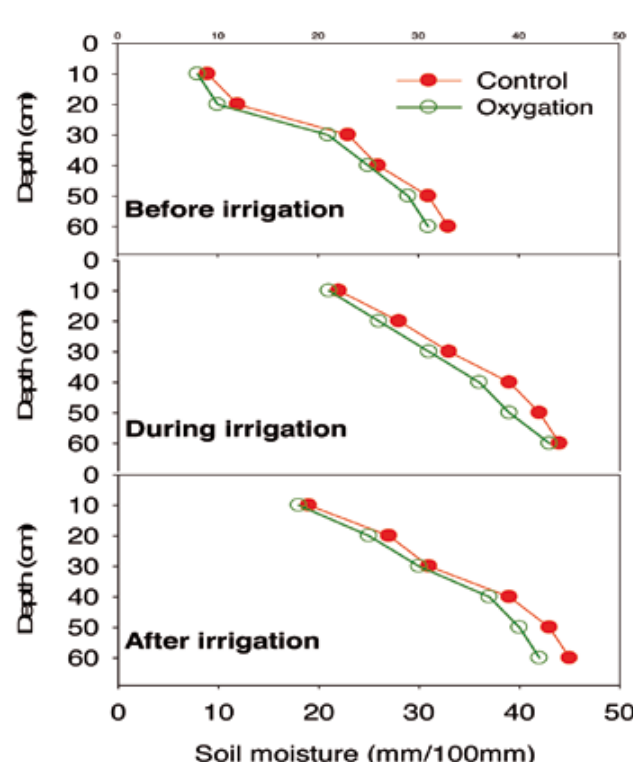
Fig. 5 - Change in soil moisture (mm water 100 mm -1 of soil depth) over a period of four days [before (2 days), during (upon completion of 2 hr irrigation) and after (2 days) irrigation] in the oxygation and control